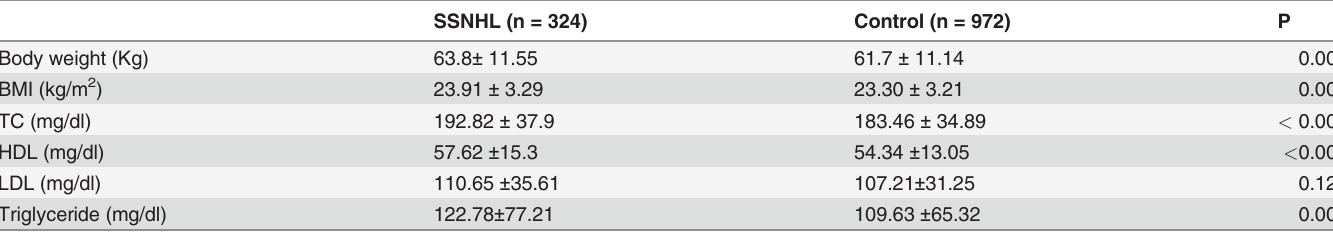
Table 2. Serum lipid profiles and obesity in SSNHL patients and matched controls.